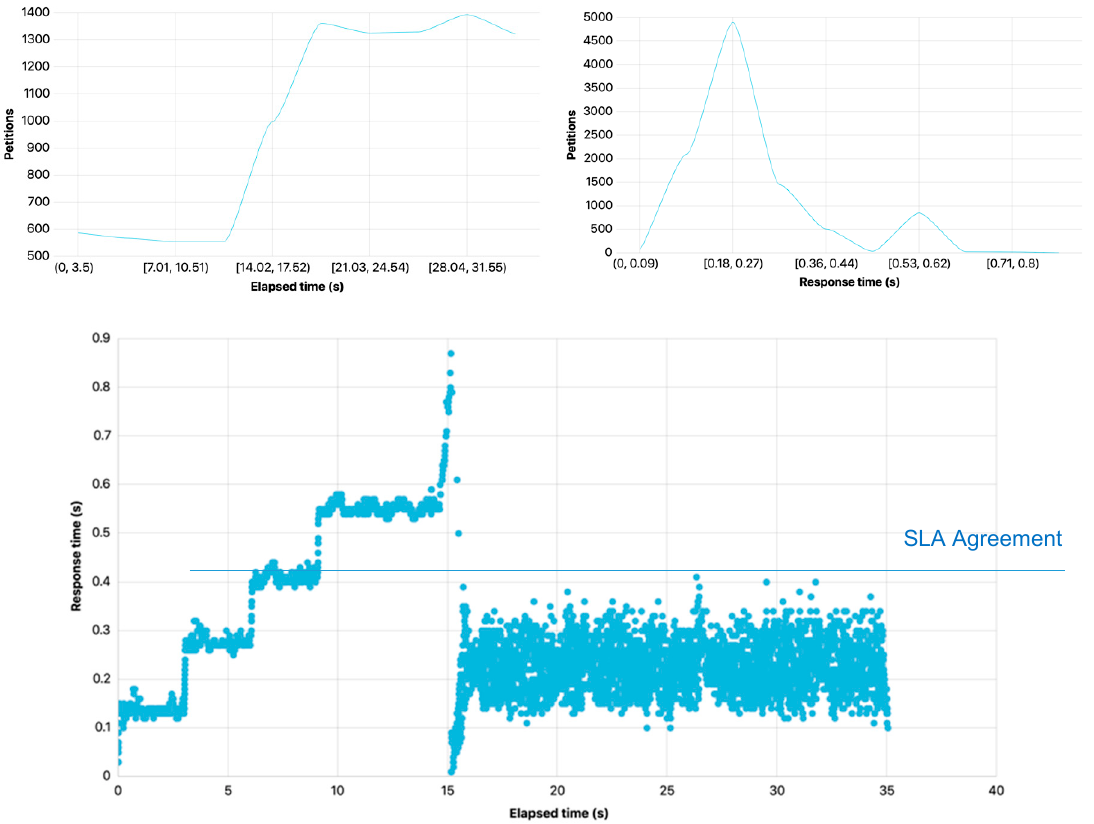
Figure 7. Experiment 1: Readjustment of the infrastructure resources for the method “GetFolderContent” (( top left ) increase in request; ( top right ) time response of request; ( bottom ) the whole adaptation process).